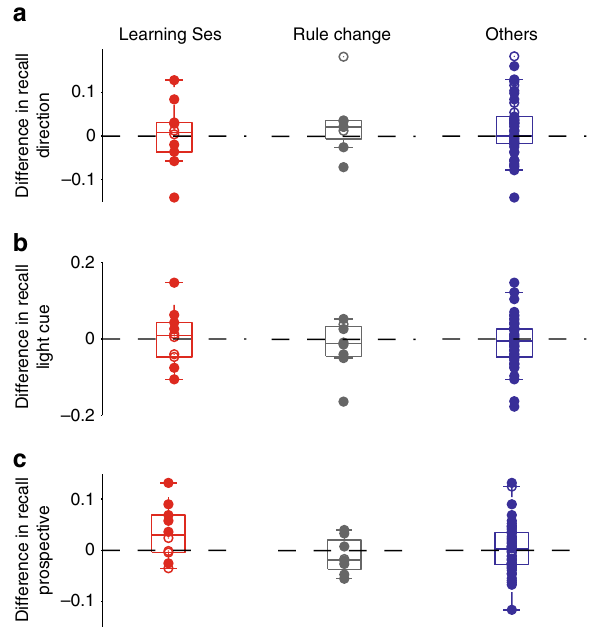
Fig. 3 Recalled ensemble activity patterns are outcome-speci fi c and encode retrospective outcome not future choice. a The difference in average recall between intervals after choosing the left arm or after choosing the right arm, sorted by session type. Filled circles here and in other panels indicate a signi fi cant difference between the distributions of recall values in the two sets of intervals (Kolmogorov – Smirnov test, P < 0.05). b As for a , but comparing intervals after the light cue appeared at the end of the left or the right arm. c The difference in average recall between intervals before error or before correct trials, testing for the prospective encoding of upcoming